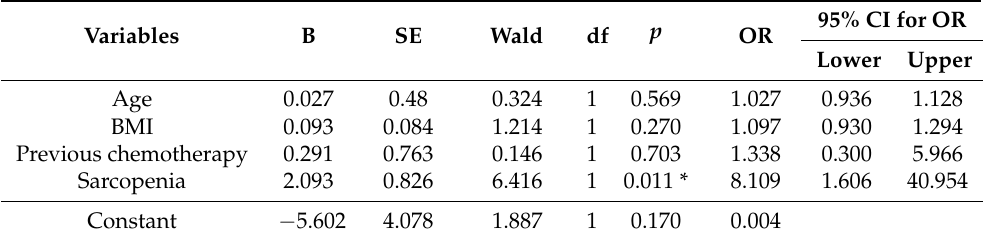
Table 3. Logistic regression predicting likelihood of progression disease (PD) as best response in patients based on age, previous chemotherapy and